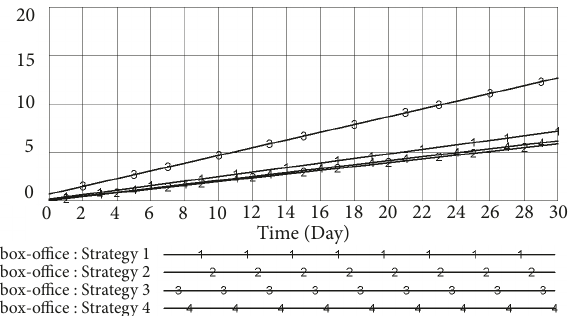
Figure 8: Box-office trend of rational audience against film release time.